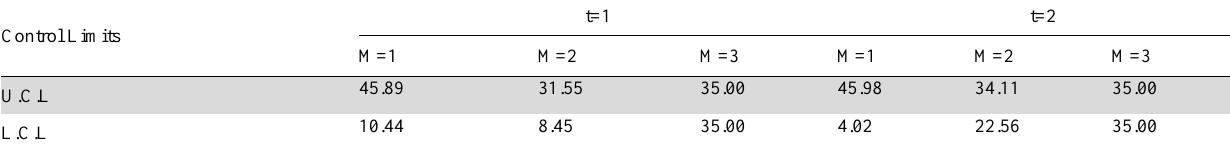
Control limits for each machine type in best observed solution for the experiment 1 Control Limits